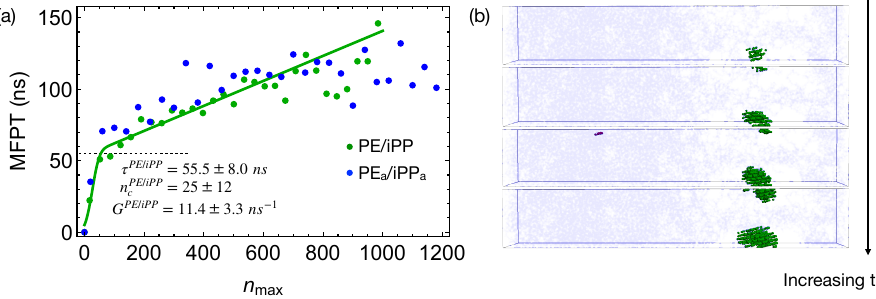
Figure 6. ( a ) MFPT for the largest crystalline nucleus to reach size n max in weakly segregated blends of PE/iPP oligomers and incompletely segregated blends of PE a /iPP a ; fitting PE/iPP data to classical nucleation theory (curve). Incubation time τ PE / iPP marked by a dashed line; ( b ) snapshots of the PE/iPP oligomer blends during isothermal nucleation. iPP atoms (light blue). Crystalline PE atoms in different nuclei (blue and purple). Amorphous PE not shown for